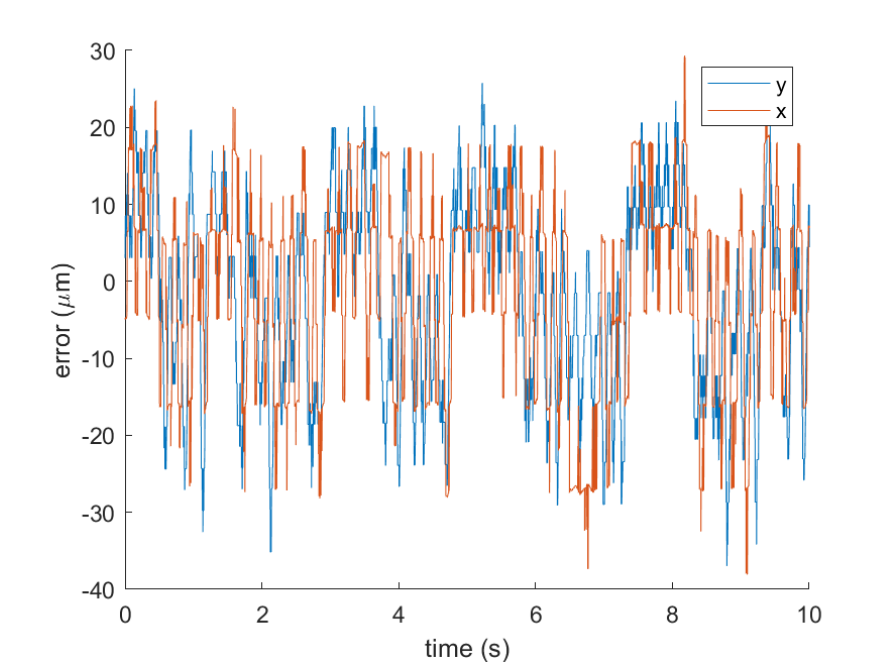
Figure 26. Tracking response of the wafer.